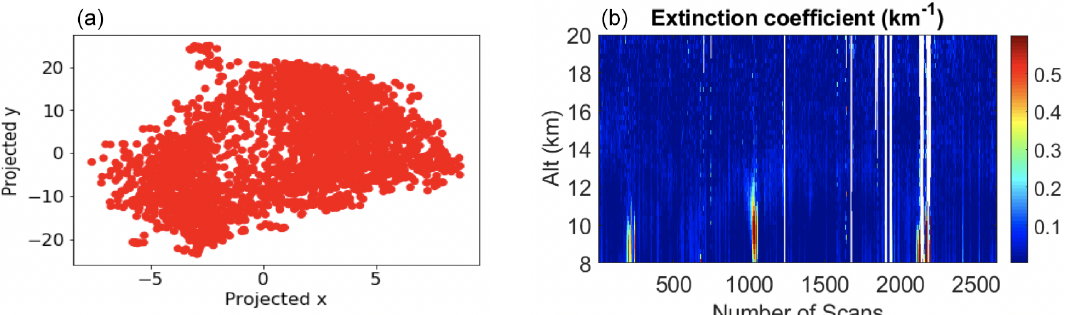
Figure 9. (a) The particle extinction profile of July 2007 indicates no significant trace of stratospheric aerosols. (b) The t -SNE generates a single cluster for all of 2637 profiles of nitrogen channel for July